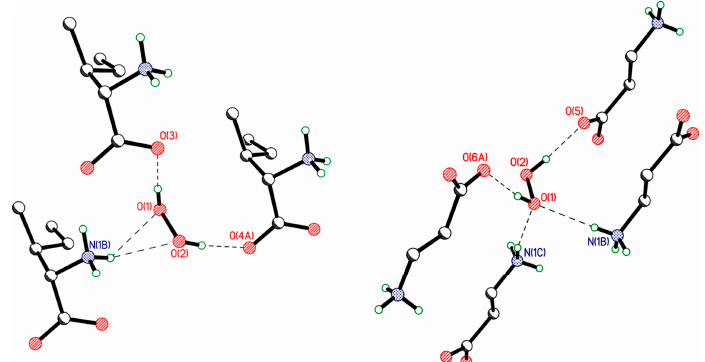
Figure 12. Bifurcate H-bonds, which are realized in isoleucine (TANDET, left panel) and β -alanine (TANDAP, right panel) peroxosolvates.